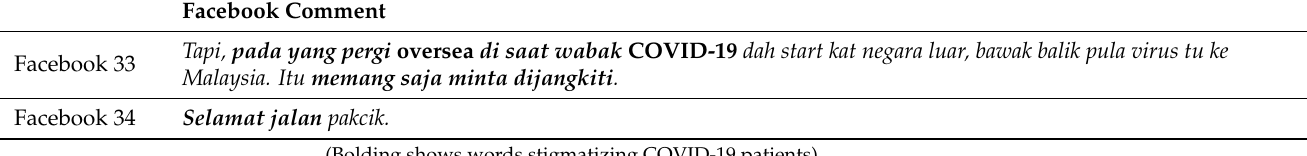
(Bolding shows words stigmatizing COVID-19 patients). Table A4. Examples of stigmatization of COVID-19 patients from certain social classes in tweets (N = 11).